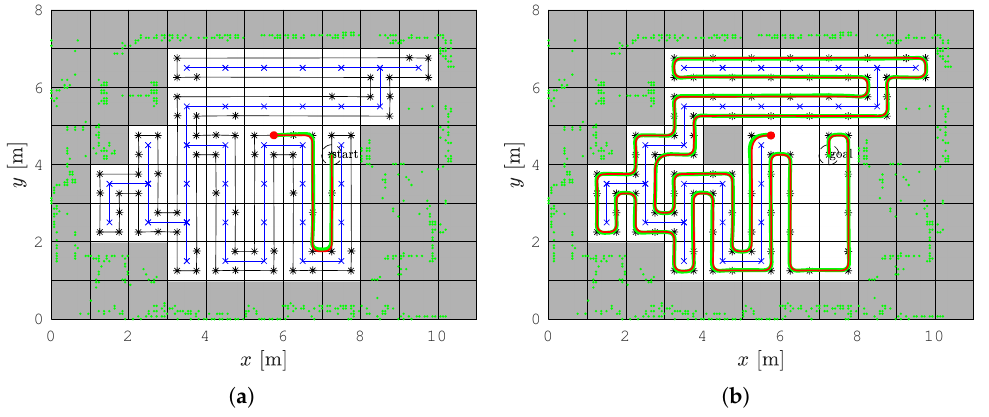
Figure 9. The RSTC algorithm in the Lab scenario with the presented RSTC spanning tree (blue line), the RSTC path (black line), the smoothed path by the SCCPP algorithm (red line), and the executed path by the smoothed RSTC algorithm (green line). Red points are the robots’ position where the replanning algorithm is executed. ( a ) The smoothed RSTC path in the Lab scenario before replanning. ( b ) The smoothed RSTC path in the Lab scenario after